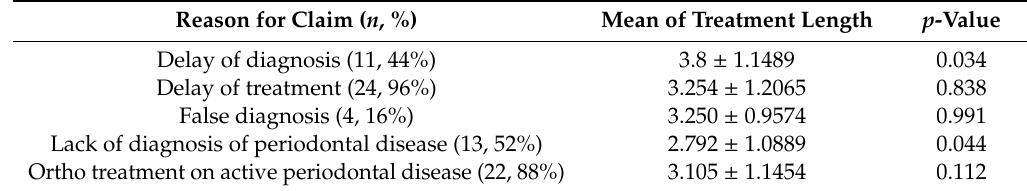
Table 5. Distribution of treatment length in the di ff erent reasons for